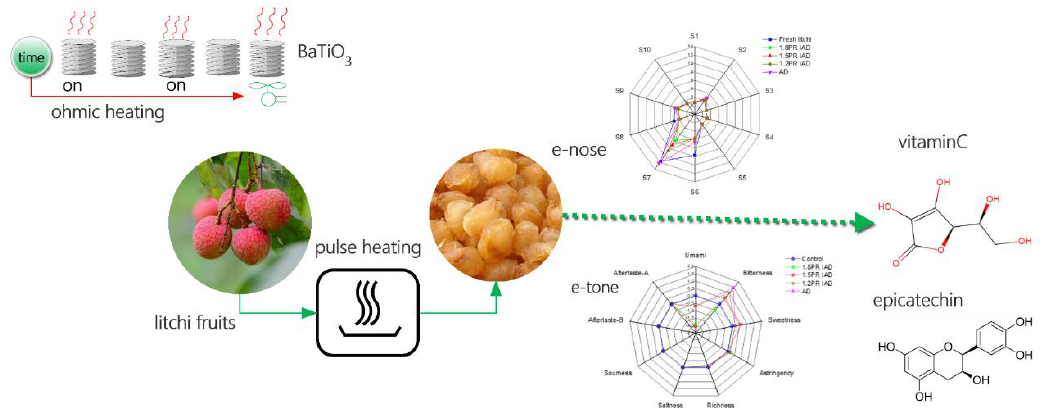
Figure 1. Flow sketch of litchi dried by drying schemes of different pulse ratios.